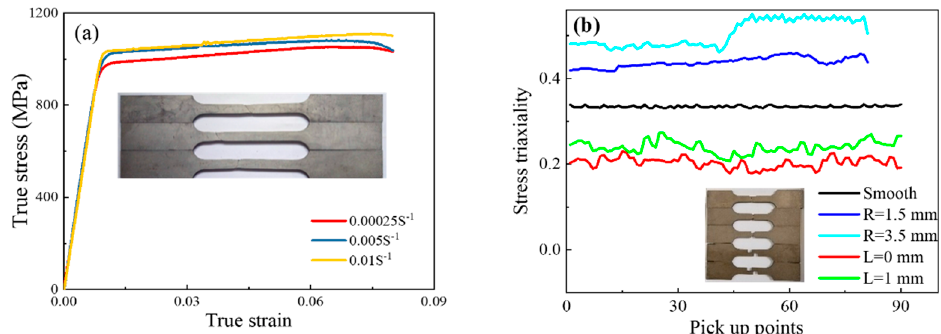
Figure 1. The sample and result curve used to establish the material model: ( a ) the tensile test sample diagram and the true stress–strain curve; ( b ) the Oyane criterion tensile test sample and the stress triaxiality value of the